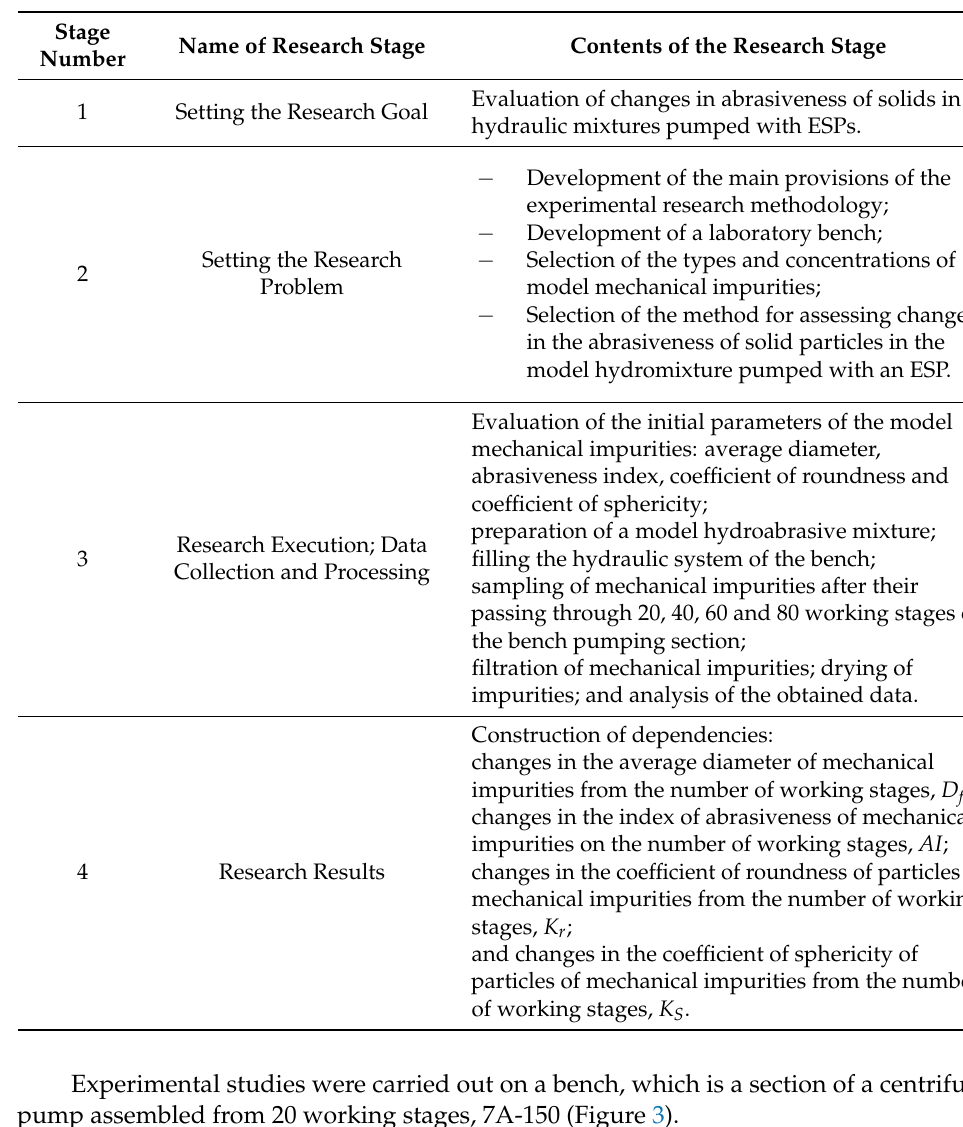
Table 1. Program of experimental research to assess changes in abrasiveness of solid particles in hydromechanical mixtures pumped with ESPs.